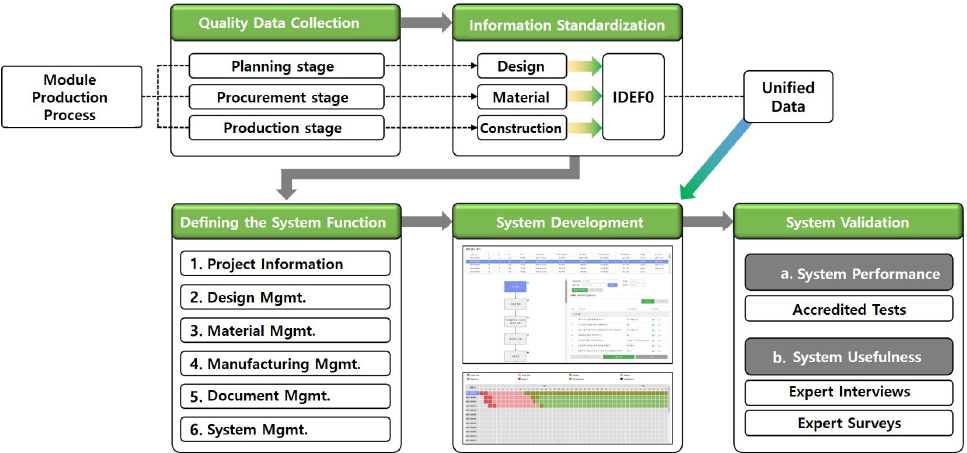
Figure 1. Framework of the development of quality information management system for modular factory.